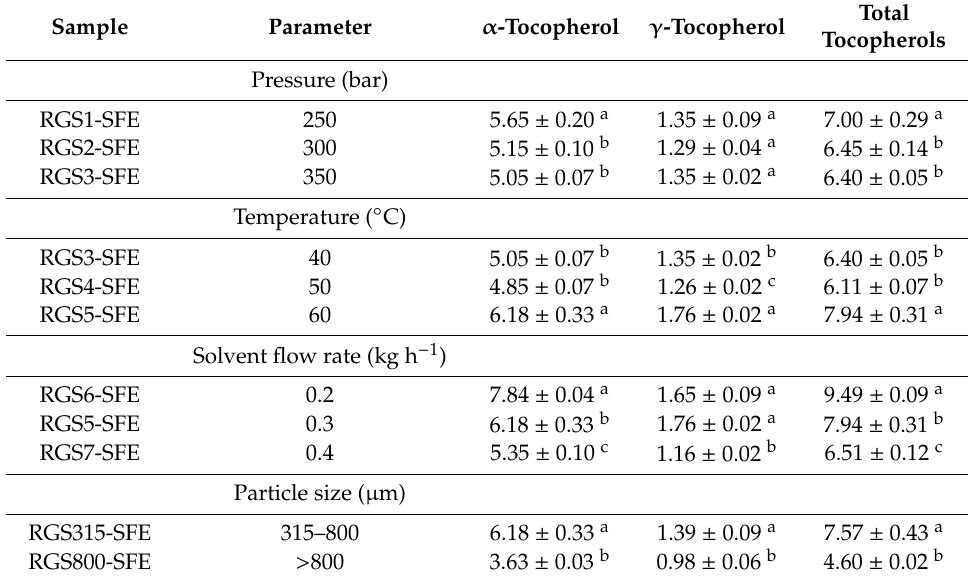
Table 4. The influence of di ff erent extraction parameters on tocopherol content in red grape seed oils recovered by supercritical fluid extraction at (mg 100 g − 1